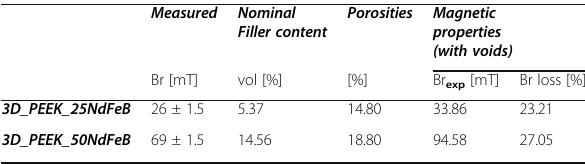
Table 15 Comparison between measured Br and expected Table 14 Expected values after apparent density measurement values for the 3D_PEEK_NdFeB samples taking into account the of the 3D_PEEK_NdFeBsamples (ideal case) presence of voids (real Measured Nominal Filler Magnetic content properties